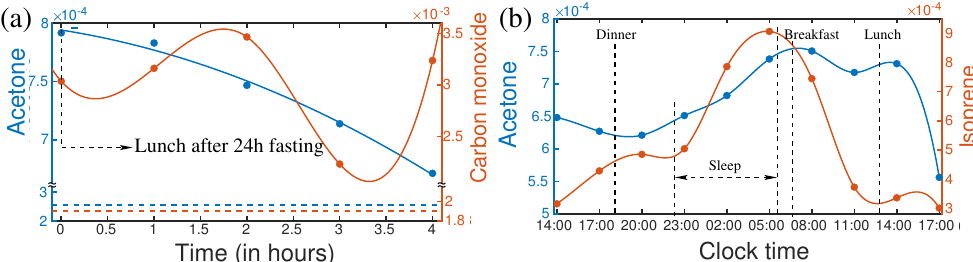
Figure 4. ( a ) Variations of isoprene and carbon monoxide after the first meal ending 24 h fasting (left). Horizontal lines are the steady-state levels of the corresponding VOCs. ( b ) Circadian variations of acetone and isoprene of a healthy person.